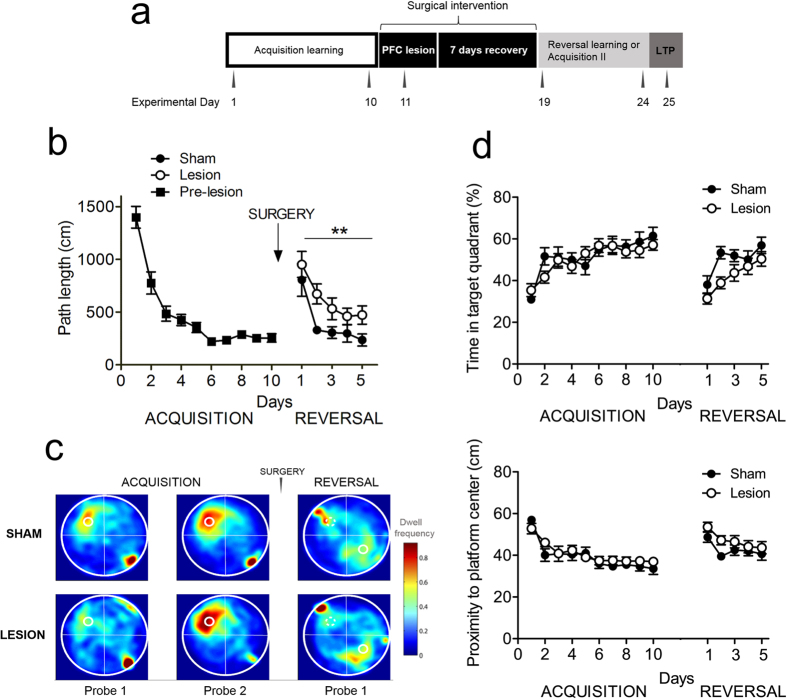
QA-induced mPFC damage impairs reversal learning in the Morris water maze.(a) Schematic of the experimental design. (b) Mice with mPFC damage (open circles) performed worse than sham-operated mice (closed circles) in acquiring new information during the reversal phase. Number of days during each phase (acquisition and reversal) is presented on the horizontal axis, average distance travelled is presented on the vertical axis. Arrow indicates the time point of the surgical manipulation. Data are expressed as means ± SEM. (c) Heat plots of search intensity during probe trials conducted on day 6 and 11 of acquisition training (first 2 panels from the left); and day 6 of reversal training (right panel). High dwell time across the MWM pool area is indicated by colors close to red, whereas colors close to blue indicate lower dwell time. Lesioned mice (bottom panel) spent more time searching in the previous platform quadrant than the new location, compared to sham animals (upper panel). The small hot spot in the right lower quadrant indicates that animals remain a few seconds at the place of release (orienting), before actually starting to navigate. (d) Time in target quadrant (upper panel) and proximity to platform (bottom panel) measurements illustrate slight but significant performance defects in lesioned mice during the reversal phase. See text for statistical analysis.